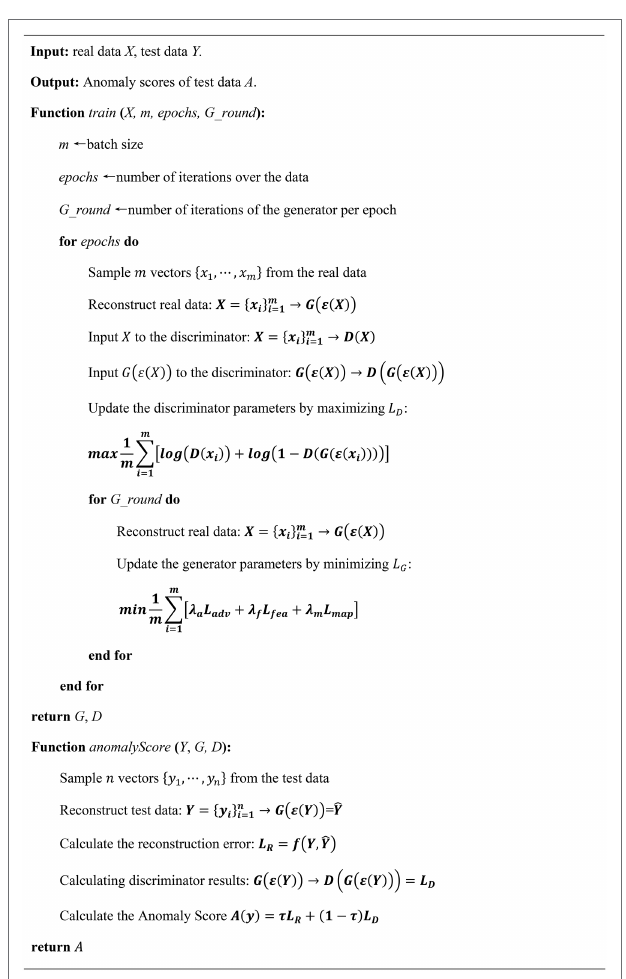
ALGORITHM 1 | Algorithm for proposed